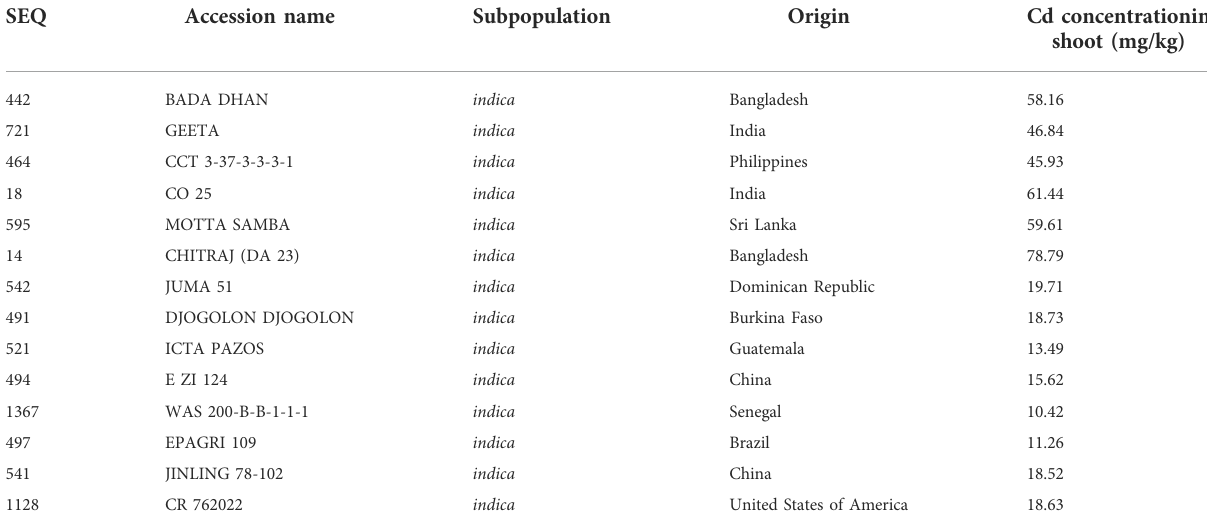
TABLE 3 High and low Cd accumulation varieties for qRT-PCR and sequence